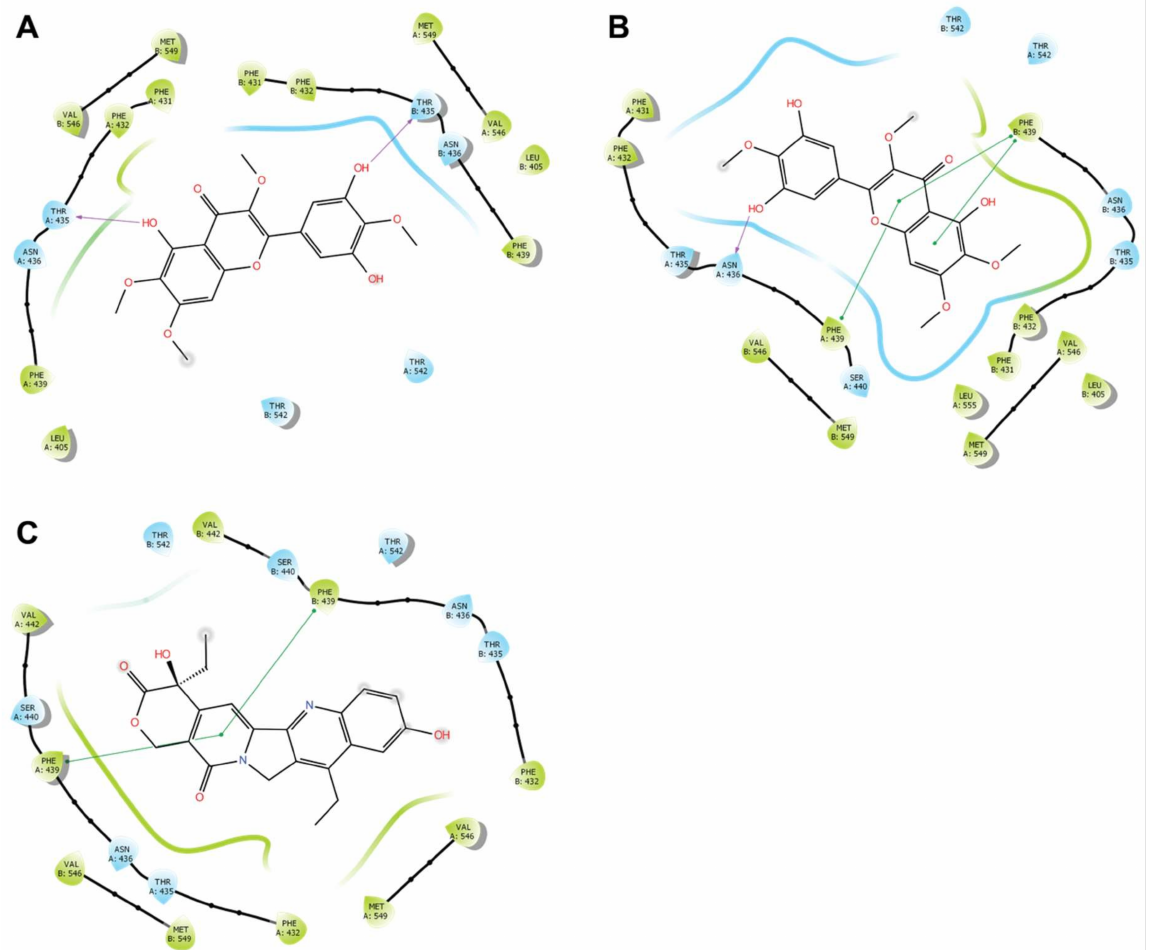
Figure 10. Overview of ligand interactions between ligand and ligand binding site in BCRP. Amino acid residues are coloured blue and green for hydrophilic and hydrophobic residues, respectively, and the surrounding of the ligand is likewise illustrated with blue and green lines. Hydrogen bonds are marked with purple lines, while π – π stacking hydrophobic interactions are marked with green lines. ( A ): Interactions between BCRP and docked 2 . ( B ): Interactions between BCRP and 2 after 600 ns MD simulation. ( C ): Interactions between BCRP and SN-38 as also seen in a previous study